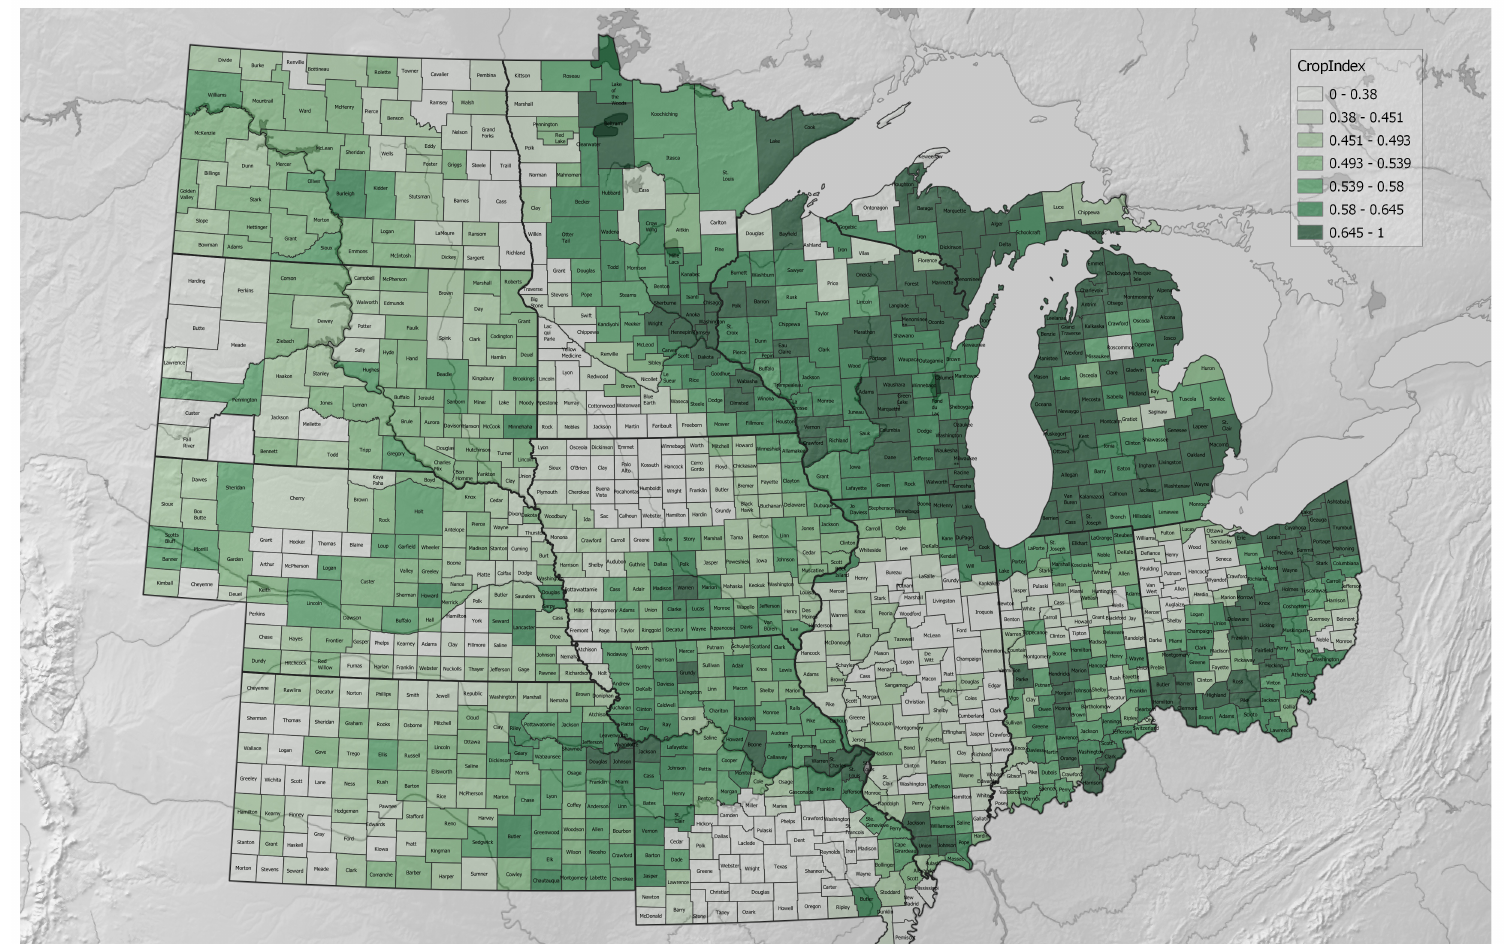
Figure A7. Crop diversity index, by county, 2017. Values were all rescaled through dividing by the largest value present for any of the counties included here (1.343 in Cook County, Illinois), as this transformation was applied to the variable data as they were placed into the index expression. Methods for CropDiversity are described in the article main text and Supplementary Materials. USDA 2017 Census of Agriculture data [52] were